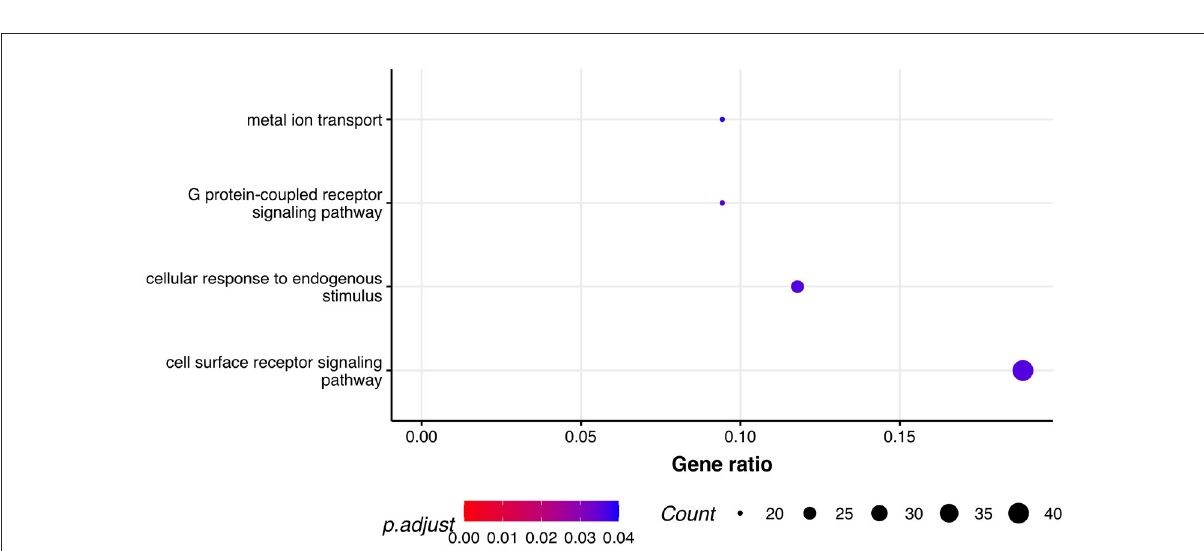
FIGURE3 Pathway analysis. Dot plot of the statistically significant GO pathways related to biological processes for respiratory score phenotype. Gene ratio represents genes related to GO terms / total number of significantly differentially expressed genes and count is the number of genes that belong to a given